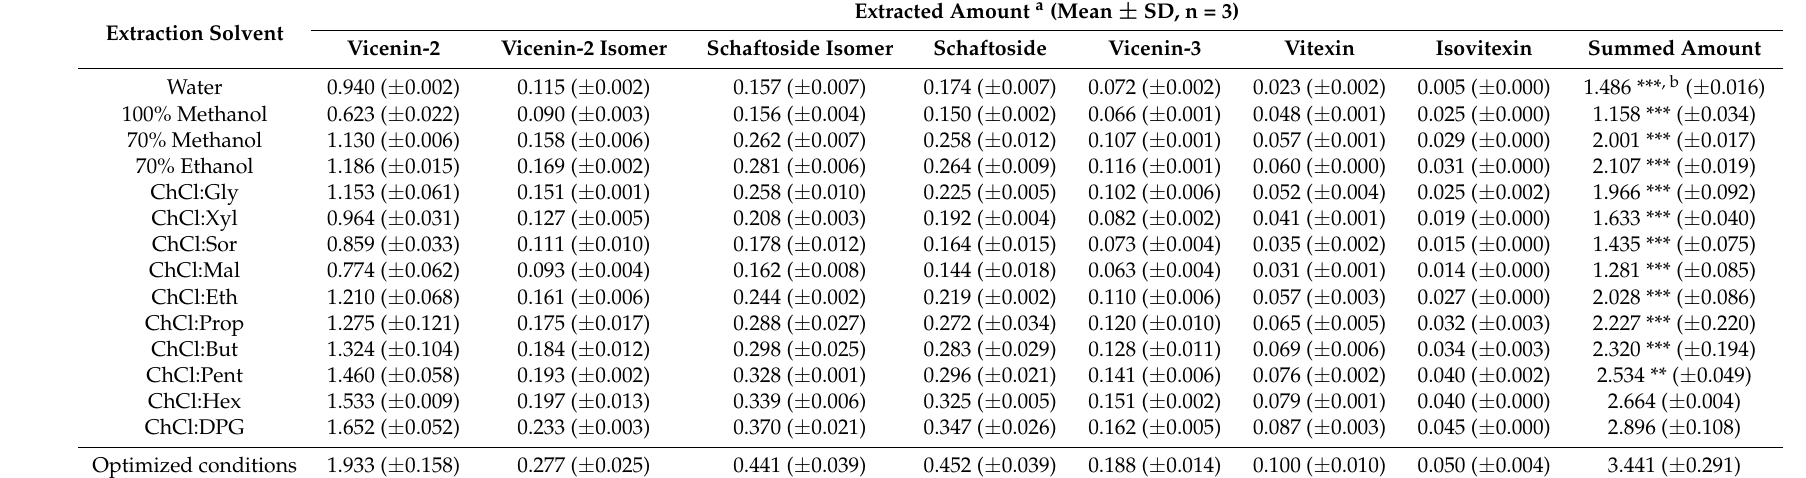
Table 3. Extraction yields for flavone C -glycosides of the tested